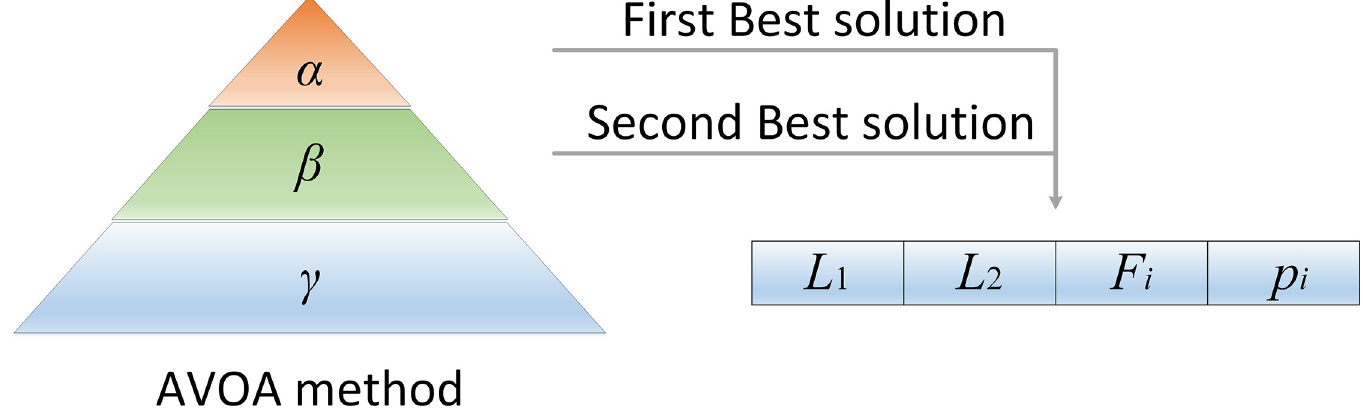
Fig 1. The relationship among the